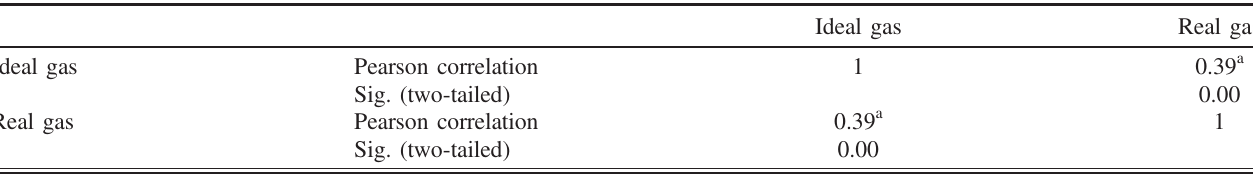
TABLE VII. Investigating the correlation between students ’ ( N ¼ 250 ) success on the ideal gas and real gas subgroups of